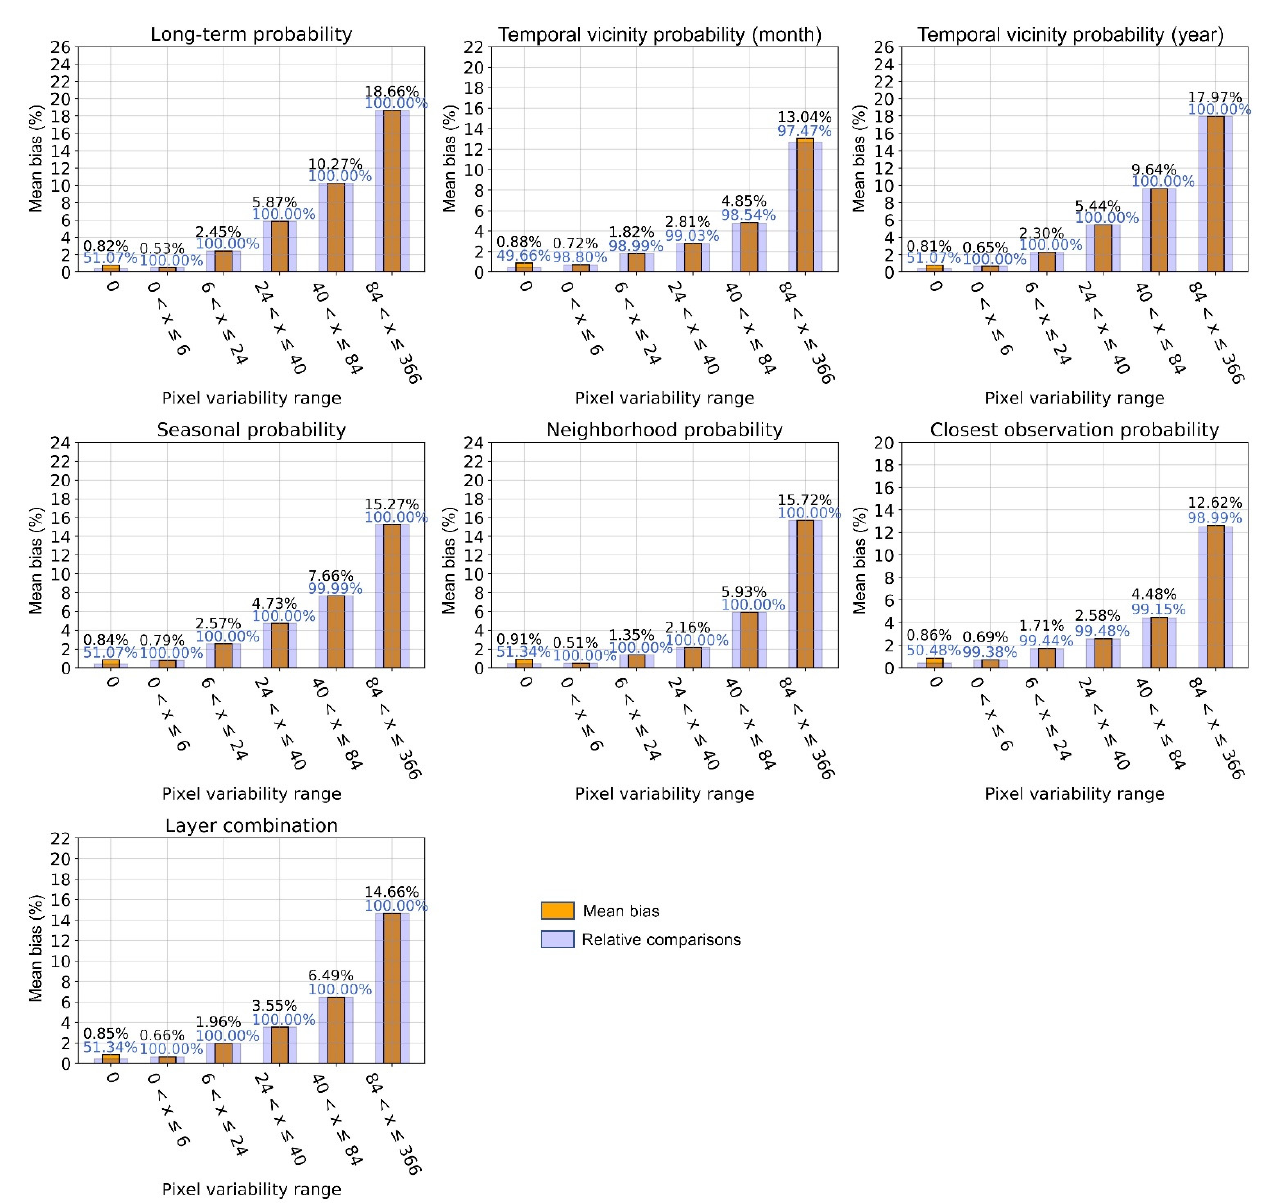
Figure 8. Evaluation results for temporal probability layers of test ROI h18v03. The blue bars show the ratio of potential comparisons (7304) to possible comparisons (layer estimate ≠ “no data”).